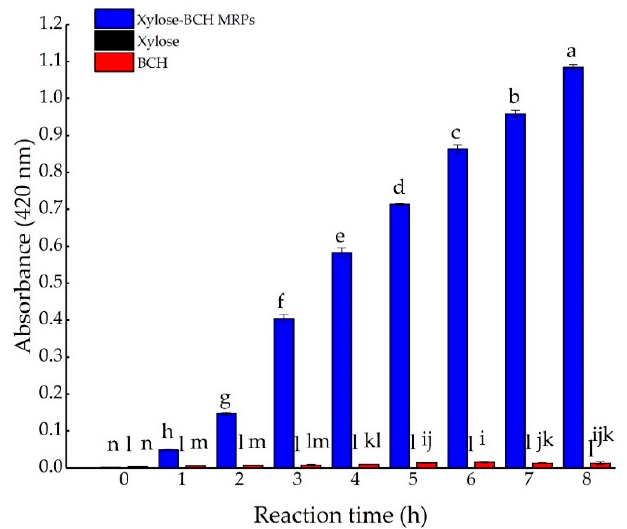
Figure A2. Effect of Maillard reaction time on browning intensity of xylose–BCH Maillard reaction products (MRPs) at pH 8.0 and 100 °C. The standard deviation is showed by error bars. Data points with diverse letters are significantly different ( p < 0.05).